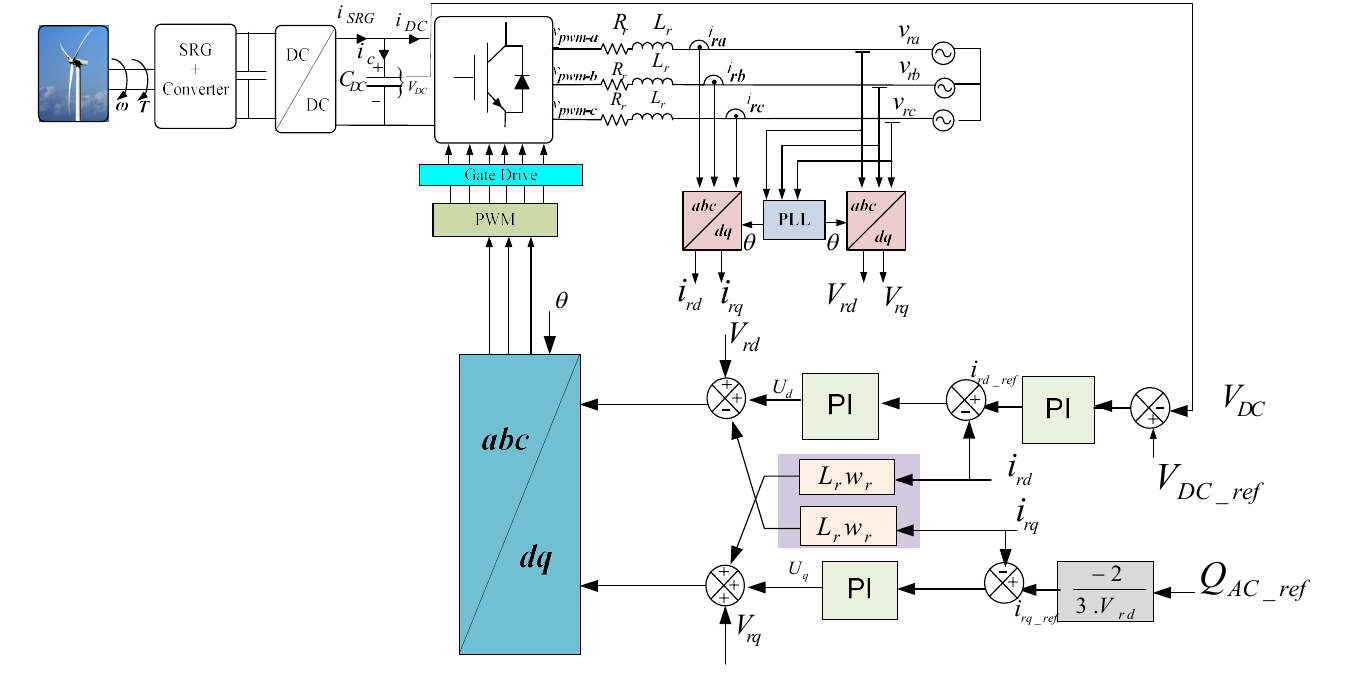
Figure 22. The bloc diagram of voltage source converter (VSC) control.